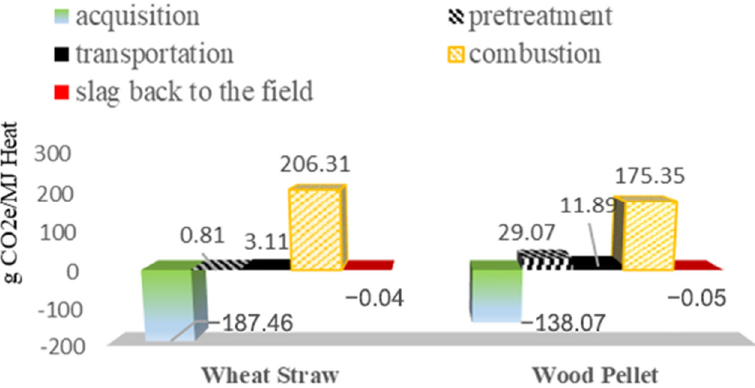
Figure 4. CO 2 e emissions distribution for cases of wheat straw and wood pellets.